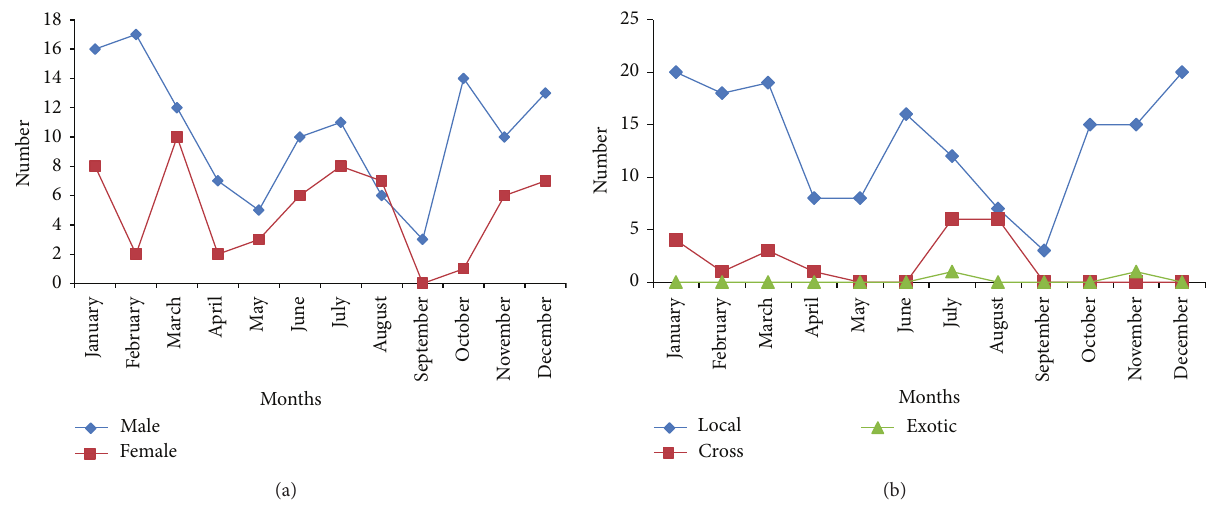
Figure 3: (a) The monthly distribution of Linguatulosis in dogs according to sexes in Jalingo, North Eastern Nigeria, for the year 2010. (b) The monthly distribution of Linguatulosis in dogs according to breeds in Jalingo, North Eastern Nigeria, for the year 2010.